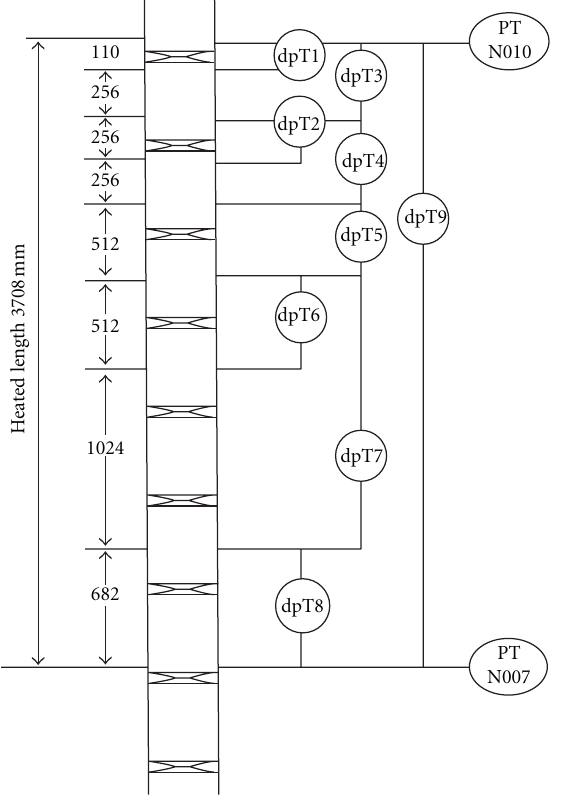
Figure 2: Locations of the pressure drop measurements. Table 1: Estimated accuracy of the measured parameters in BFBT test [8].